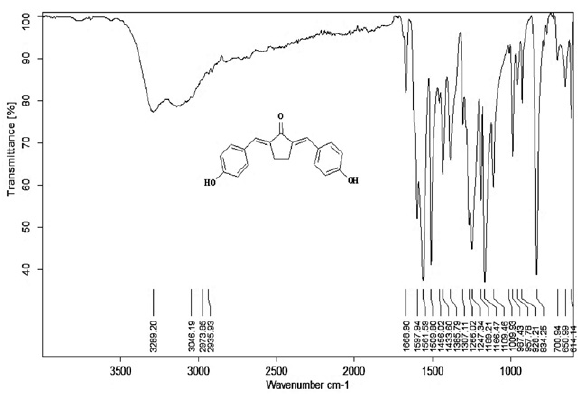
Figure 2: FT IR spectrum for chalcone A .